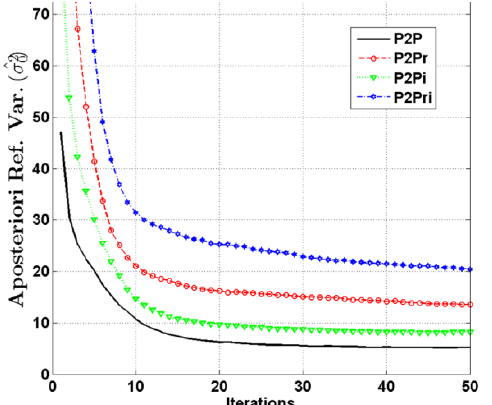
Figure 4: Comparison of Registration Methods. The y-axis gives the root mean square point-to-plane